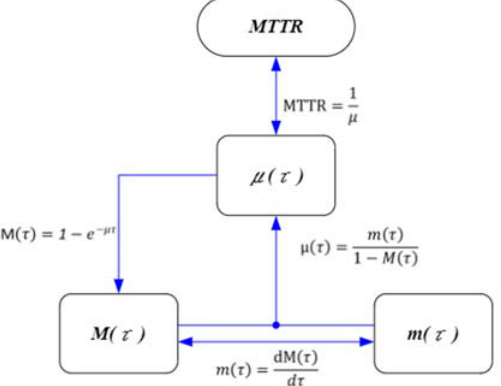
Figure 3. Correlation diagram of maintainability function.